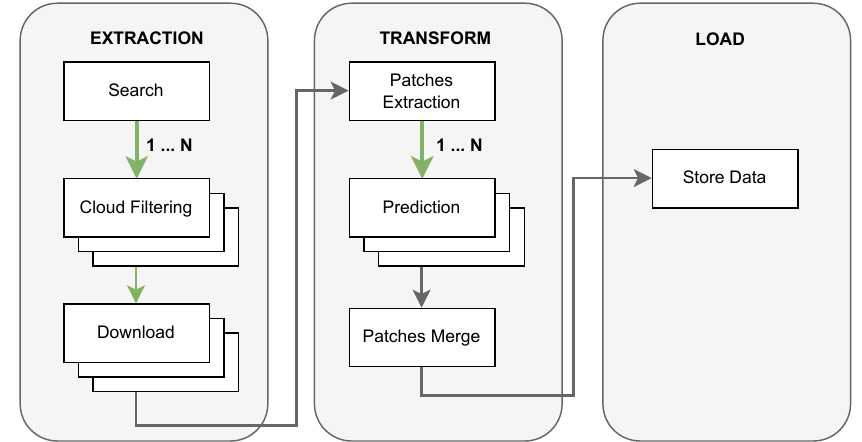
Figure 7. Schematic representation of the inference pipeline